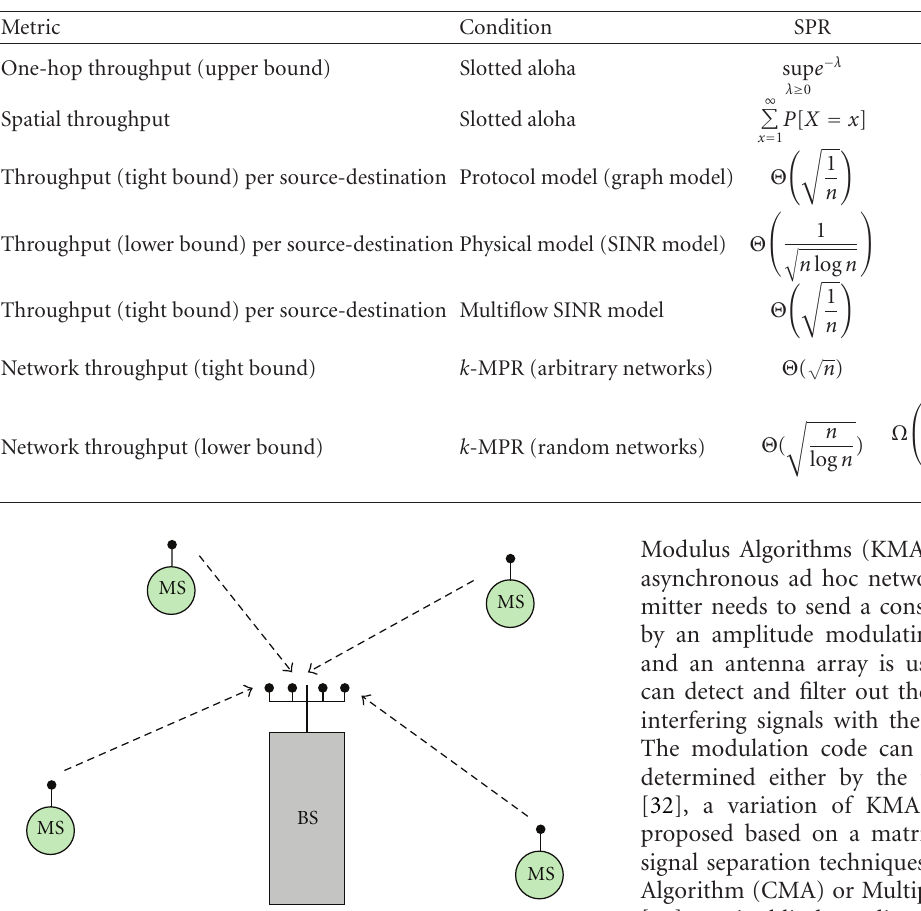
Table 1: Theoretical results on the capacity.